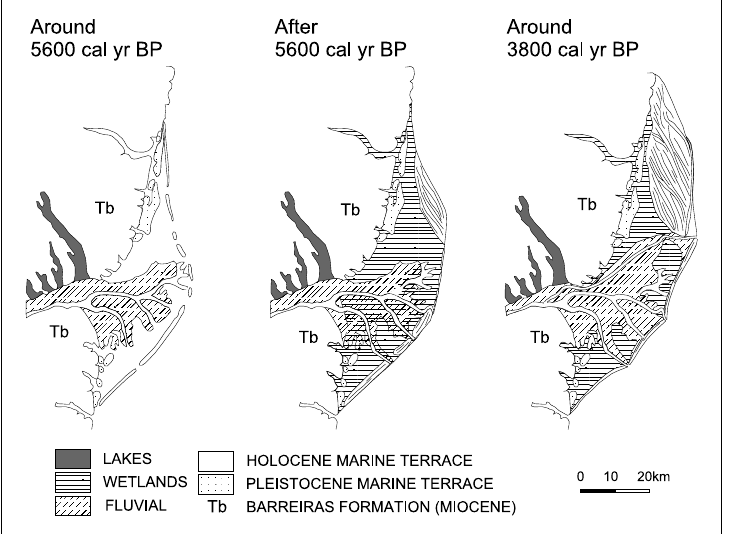
Fig. 3 – Paleogeographic maps of the coastal plain associated to Doce River mouth from 5600 to 3800 cal yr BP. (according to data from Dominguez 1987, Dominguez and Wanless